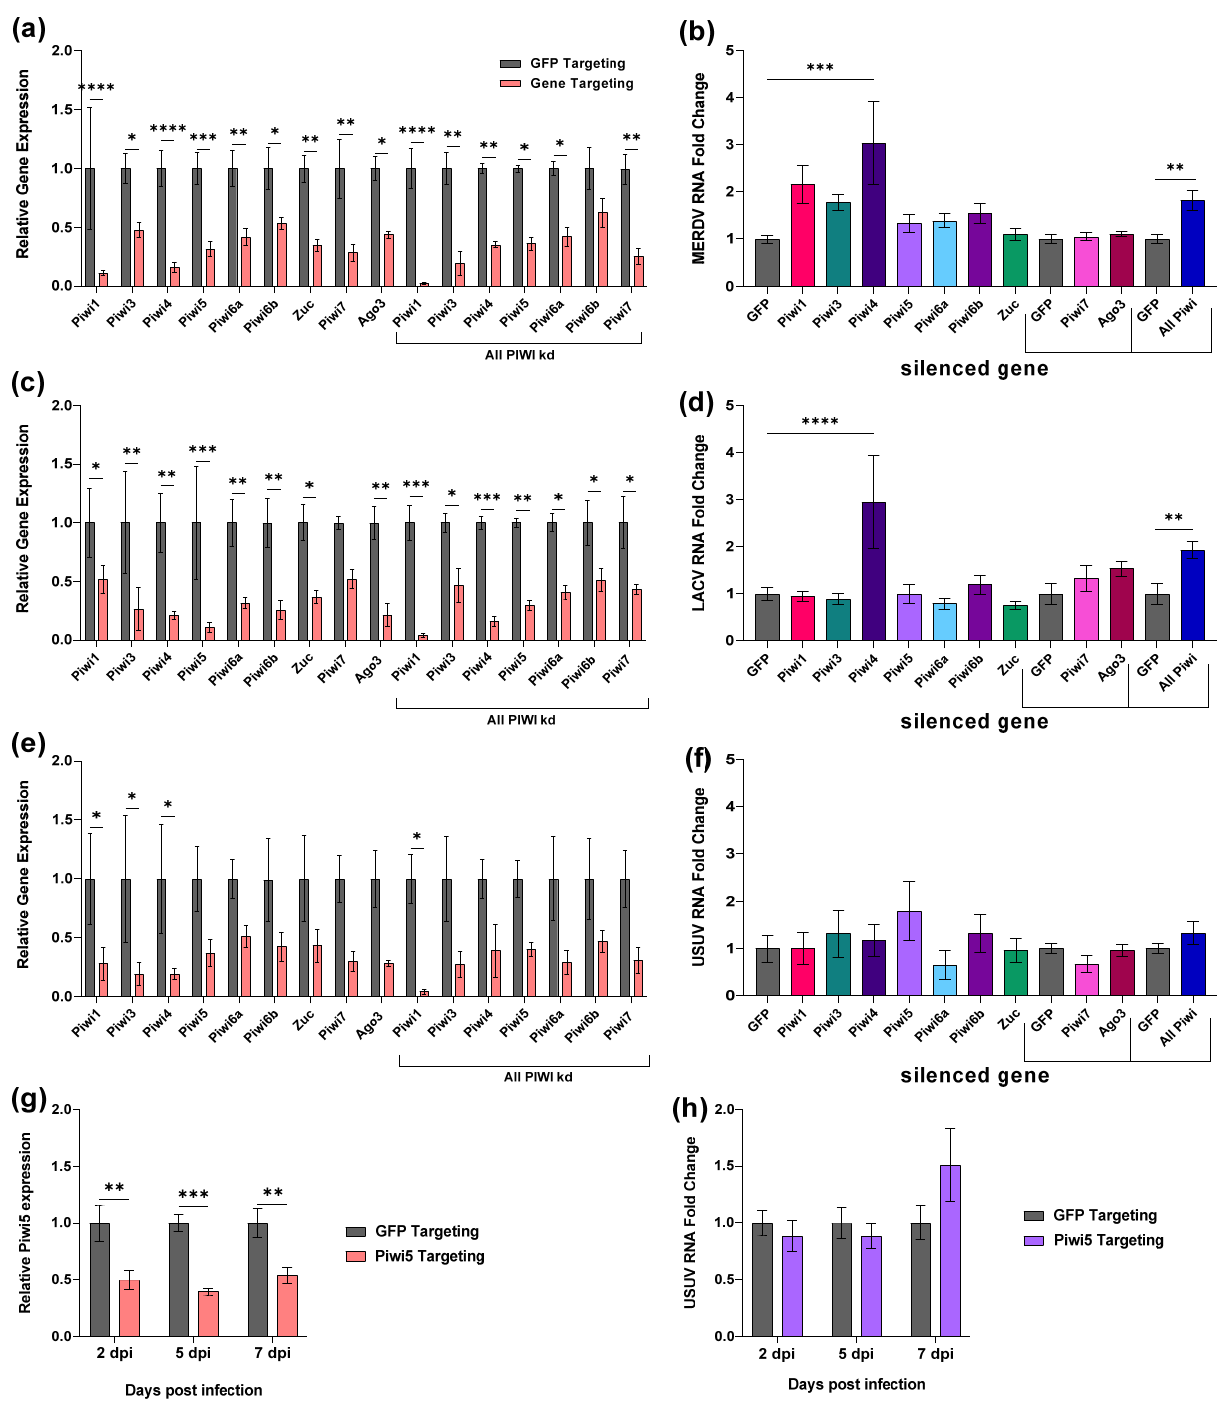
Figure 2. Impact of Cx. quinquefasciatus PIWI gene silencing on virus replication. Hsu cells were left uninfected ( a , b ) or were infected 2 days post ‐ transfection with LACV MOI 10 ( c , d ), USUV MOI 50 ( e – h ). Cellular RNA was extracted at 2 dpi ( a – f ) or 2, 5, 7 dpi ( g , h ). Silencing efficiency of PIWI genes ( a , c , e , g ) and viral RNA levels ( b , d , f , h ) were determined by qRT ‐ qPCR. Bars are the mean +/ − SEM of 2 ( g , h ) or 3 ( a – f ) independent experiments with 3 biological replicates each. Brackets in ( b , d , f ) indicate that separate experiments were performed for Piwi7 and Ago3, and all PIWI genes, including separate GFP controls. Significant changes in RNA abundance compared to the GFP control are shown as * p < 0.05, ** p < 0.01, *** p < 0.001, **** p < 0.0001.